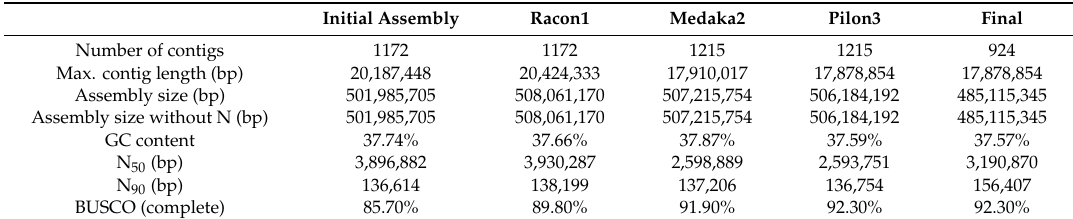
Table 1. Statistics of selected versions of the Dioscorea dumetorum genome assembly (see File S5 for a full table). Initial Assembly